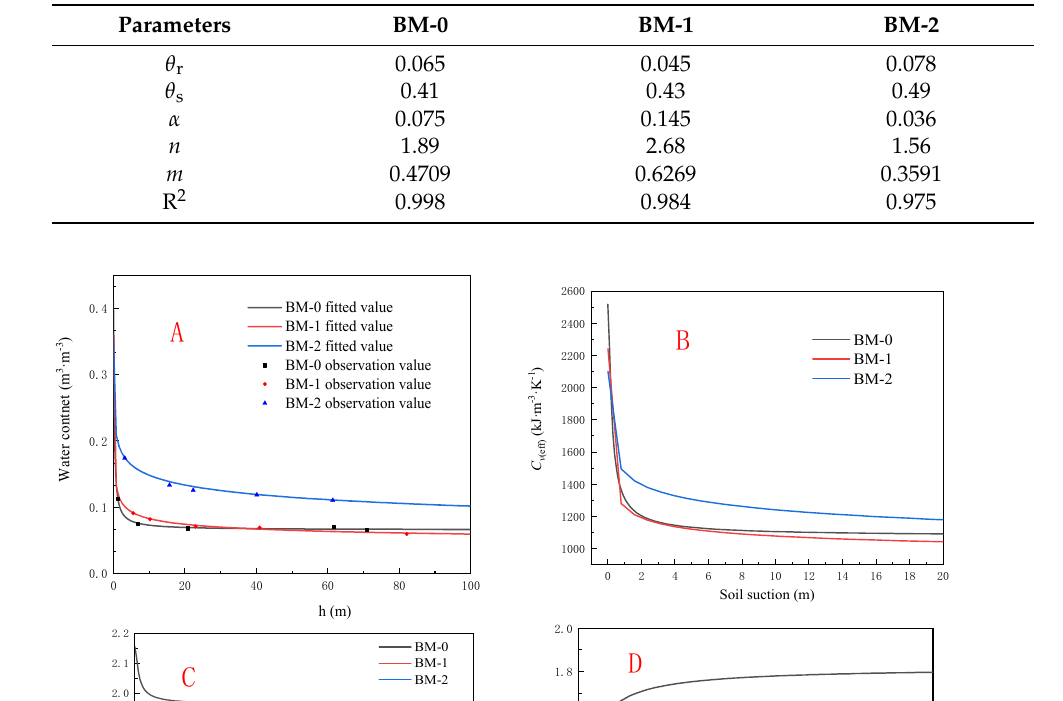
Table 3. Parameters of the soil–water characteristic curves.